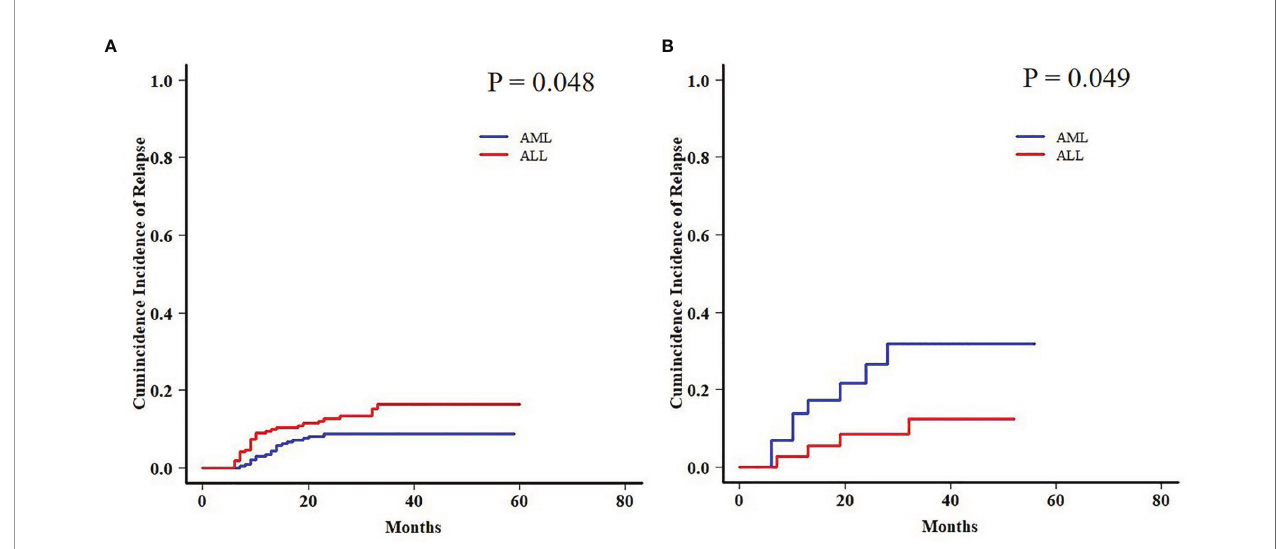
FIGURE 5 | Late effect on CIR between AML and ALL patients. (A) Late effect on CIR between AML and ALL patients in the whole cohort. (B) Late effect on CIR between AML and ALL patients in the EBV+/CMV −